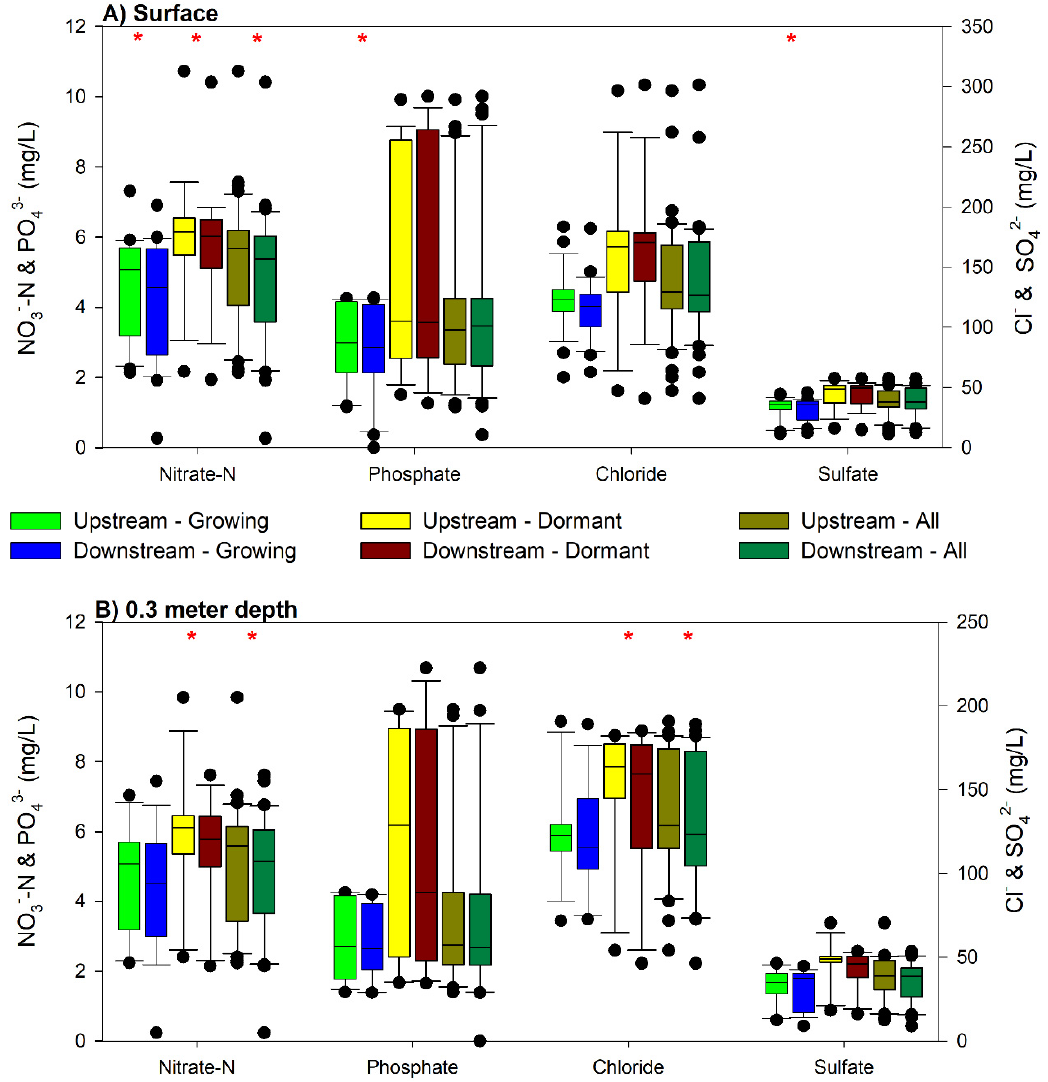
Figure 3. Measured anion concentrations in the waters upstream and downstream of the AFW differentiated by season (growing or dormant) and collectively (all) for ( A ) surface waters and ( B ) waters at a 0.3 m depth. The red asterisk ( * ) signifies statistically significant differences between the upstream concentration and the downstream concentration for the given anion.